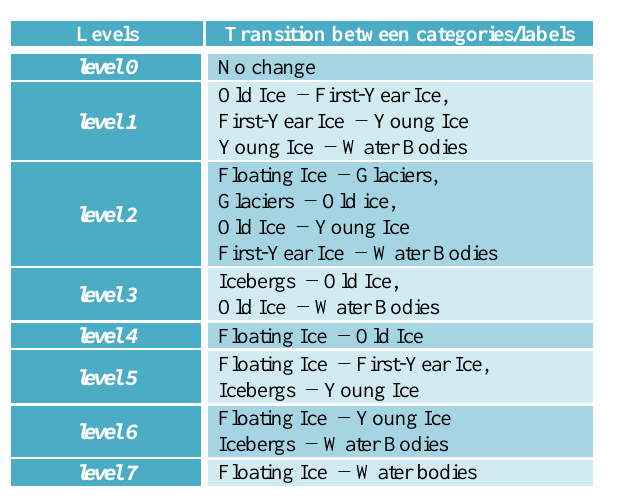
Figure 6. Quantitative analysis of the semantic categories that were extracted from the area of interest using the Sentinel-1 image acquired on April 17 th , 2018 (top) and the Sentinel-1 image acquired on June 16 th , 2018 (bottom). The semantic change was determined also quantitatively (center).